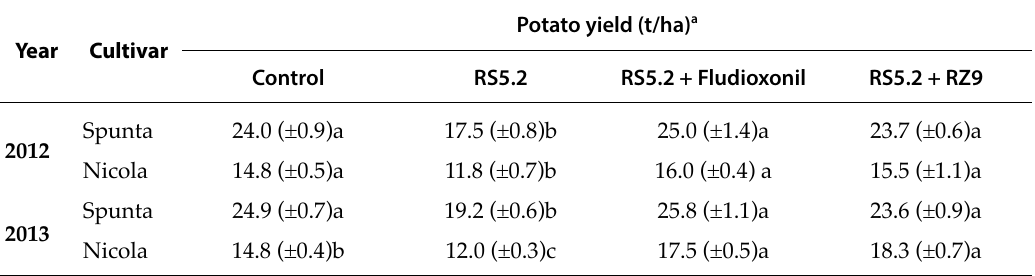
Table 3. Mean potato yields (t/ha) in the field biocontrol trials of Rhizoctonia solani (RS5.2) with the strain RZ9 of Pseu- domonas aeruginosa , conducted in the region Sned-Gafsa during 2012 and 2013 growing seasons, using the potato cultivars Spunta and